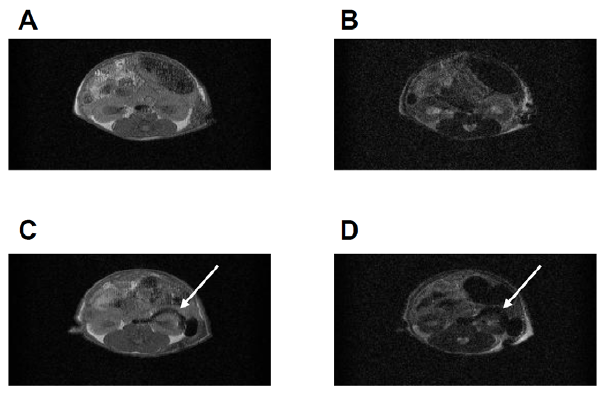
Figure 3. In vivo MRI of transplanted MIN6 cells labeled with TMADM-03. A. T1-weighted images of MIN6 cells without TMADM-03 transplanted into the left kidney capsule. B. T2-weighted images of MIN6 cells without TMADM-03 transplanted into the left kidney capsule. C. T1-weighted images of MIN6 cells labeled with TMADM-03 transplanted into the left kidney capsule. D. T2-weighted images of MIN6 cells labeled with TMADM-03 transplanted into the left kidney capsule. The arrows show the transplanted graft.